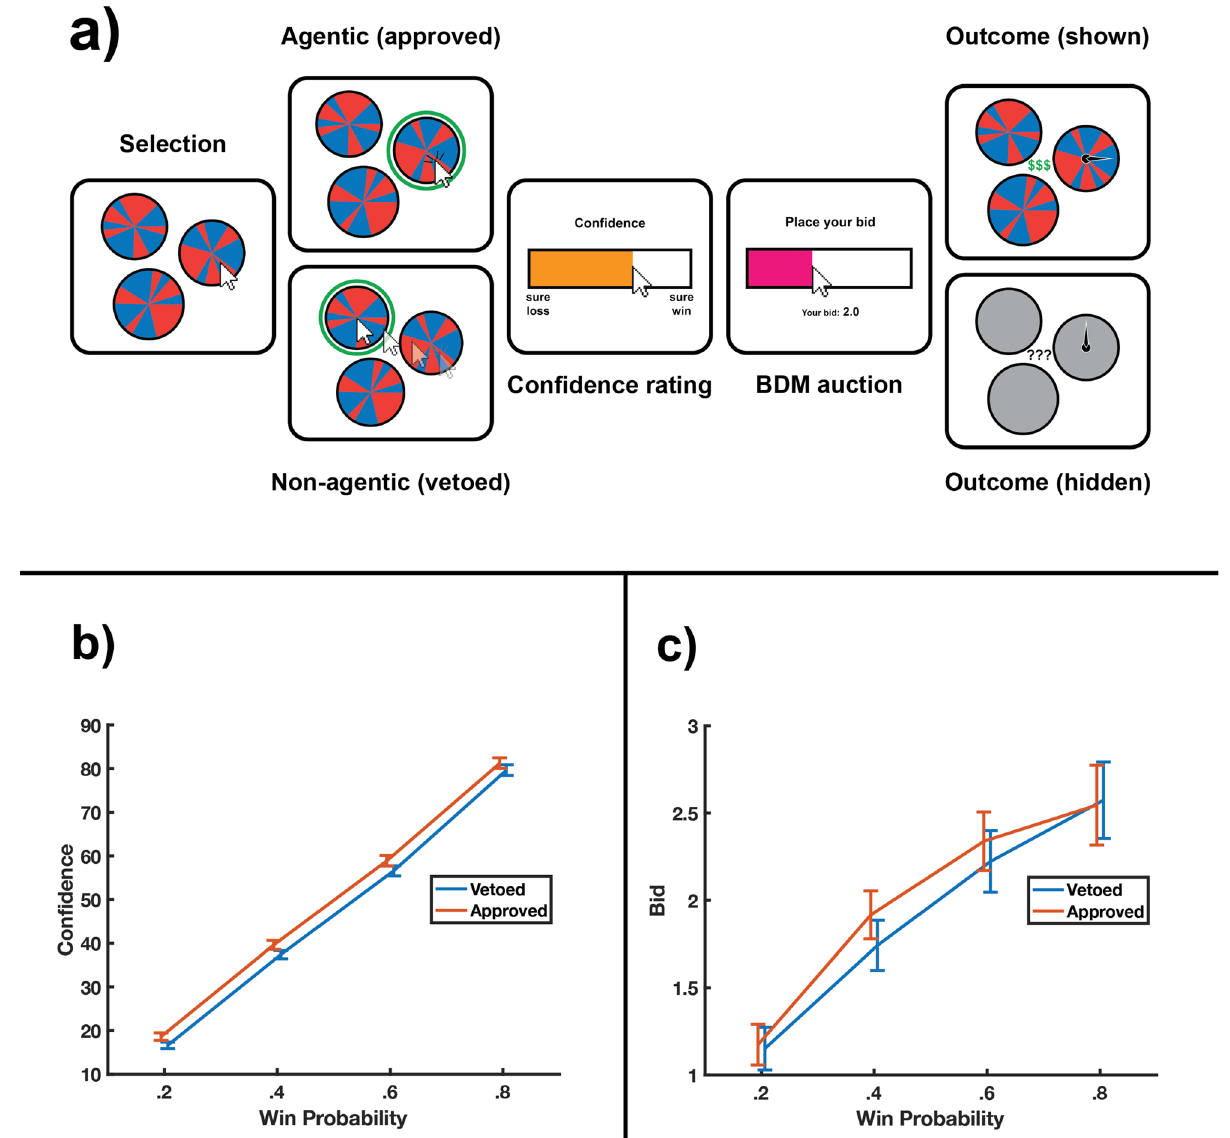
Figure 1. Experimental design and results. ( a ) On each trial, participants made a selection between three equivalent roulette wheels. Their choice was either approved or vetoed, in which case the cursor was moved to and selected an alternative option. They then rated their confidence to win that trial and submitted a bid in a Becker–DeGroot–Marschak (BDM) auction to determine whether the outcome would be revealed or hidden. If their bid was successful, the outcome was shown, otherwise, it was hidden. ( b ) Mean confidence ratings (on a scale from 0 = “sure loss” to 100 = “sure win”) for each possible probability of winning. Confidence ratings were significantly higher when participants’ selection of lottery was approved. Error bars represent the standard error of the mean. ( c ) Mean bid size in points for each possible probability of winning. Bids were significantly larger when participants’ selection of lottery was approved. Error bars represent the standard error of the